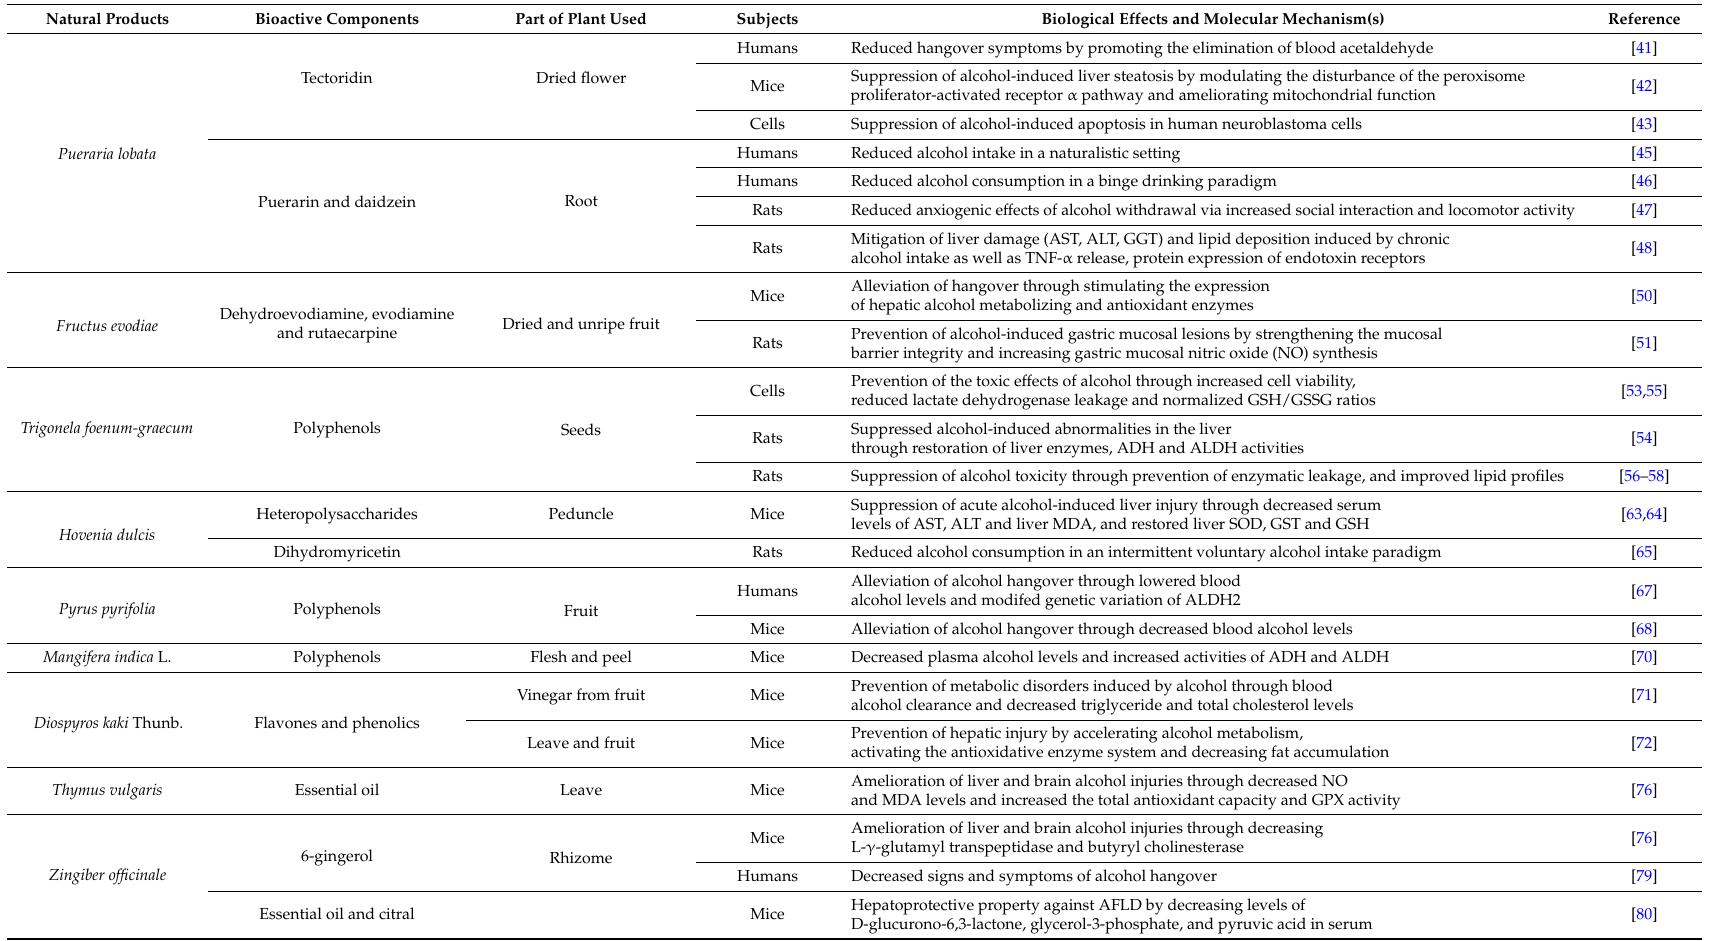
Table 1. Natural products for the prevention and treatment of hangover and alcohol use